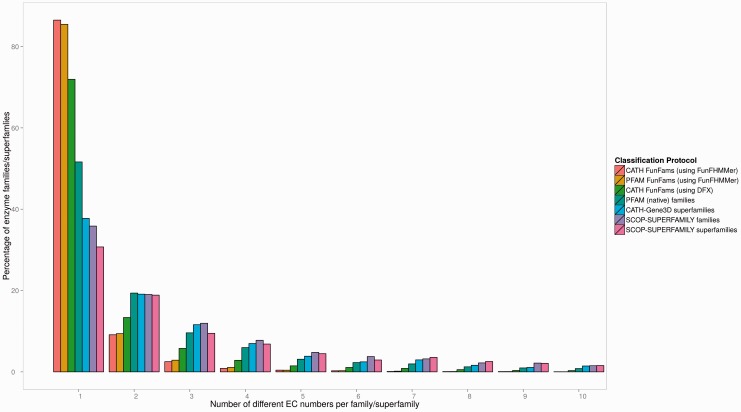
EC number variation across protein classifications. Percentage of families or superfamilies having a certain number of EC terms for each of the domain-based protein classifications